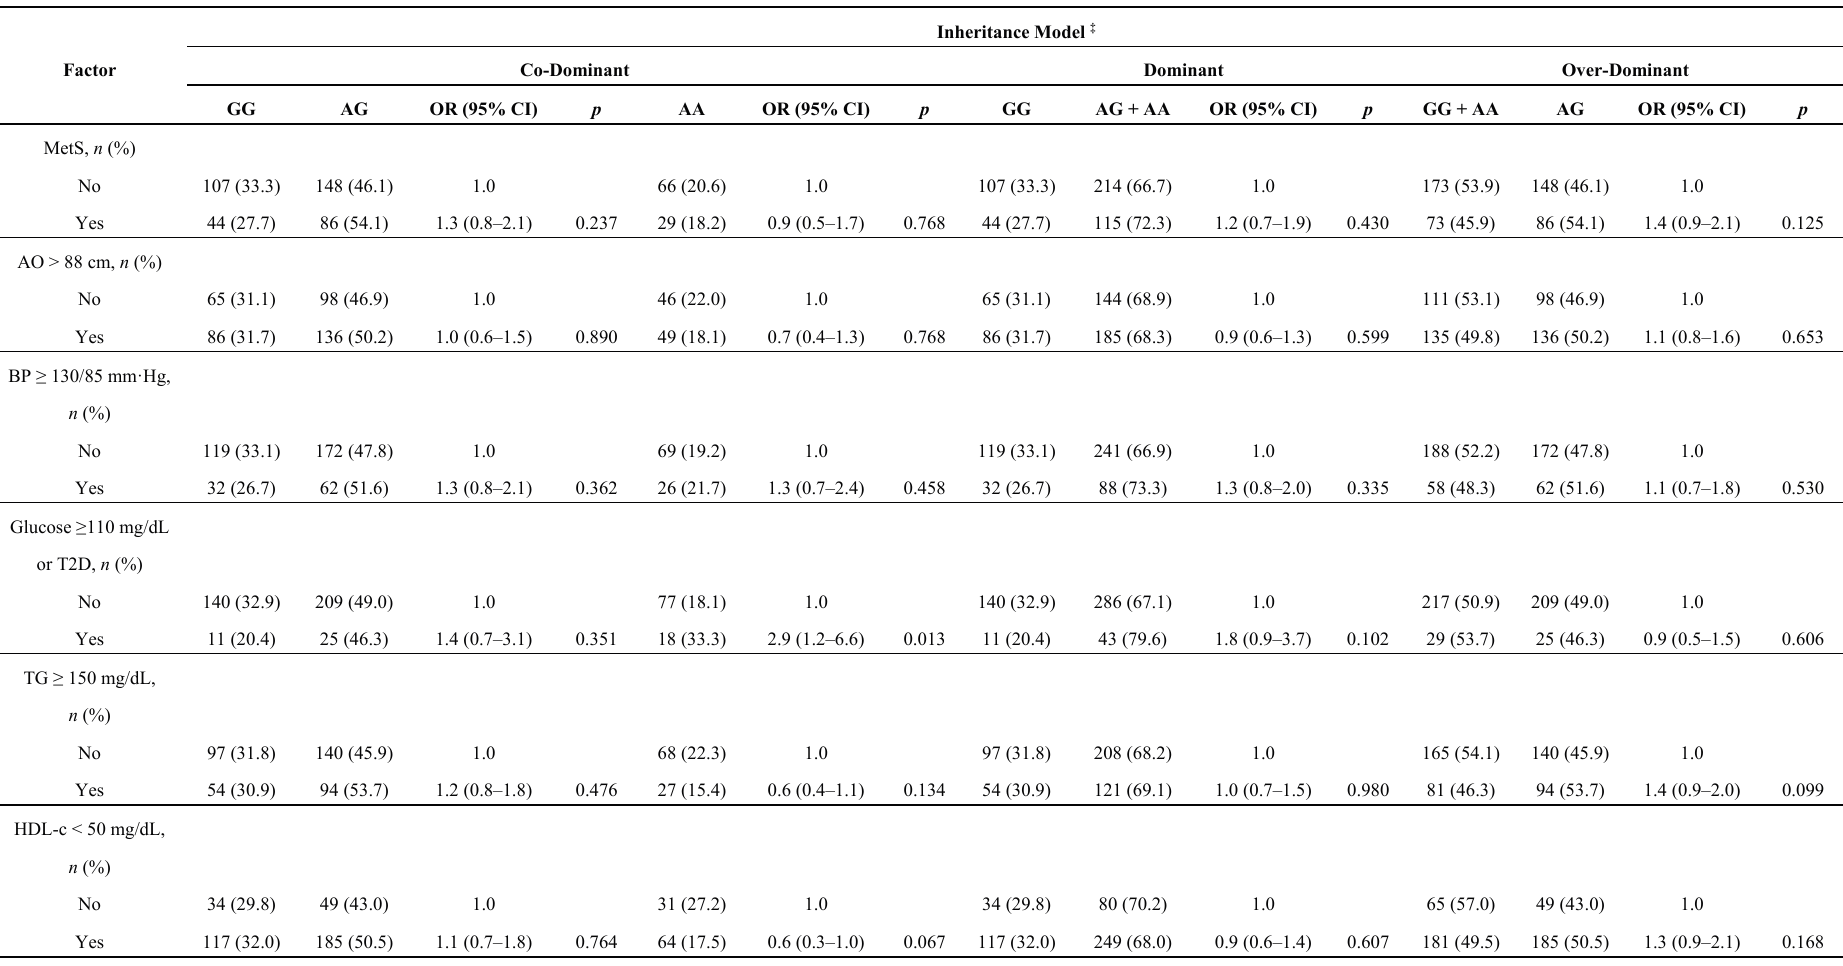
Table 3. Association between SNP rs1884051 in ESR1 gene with MetS and their